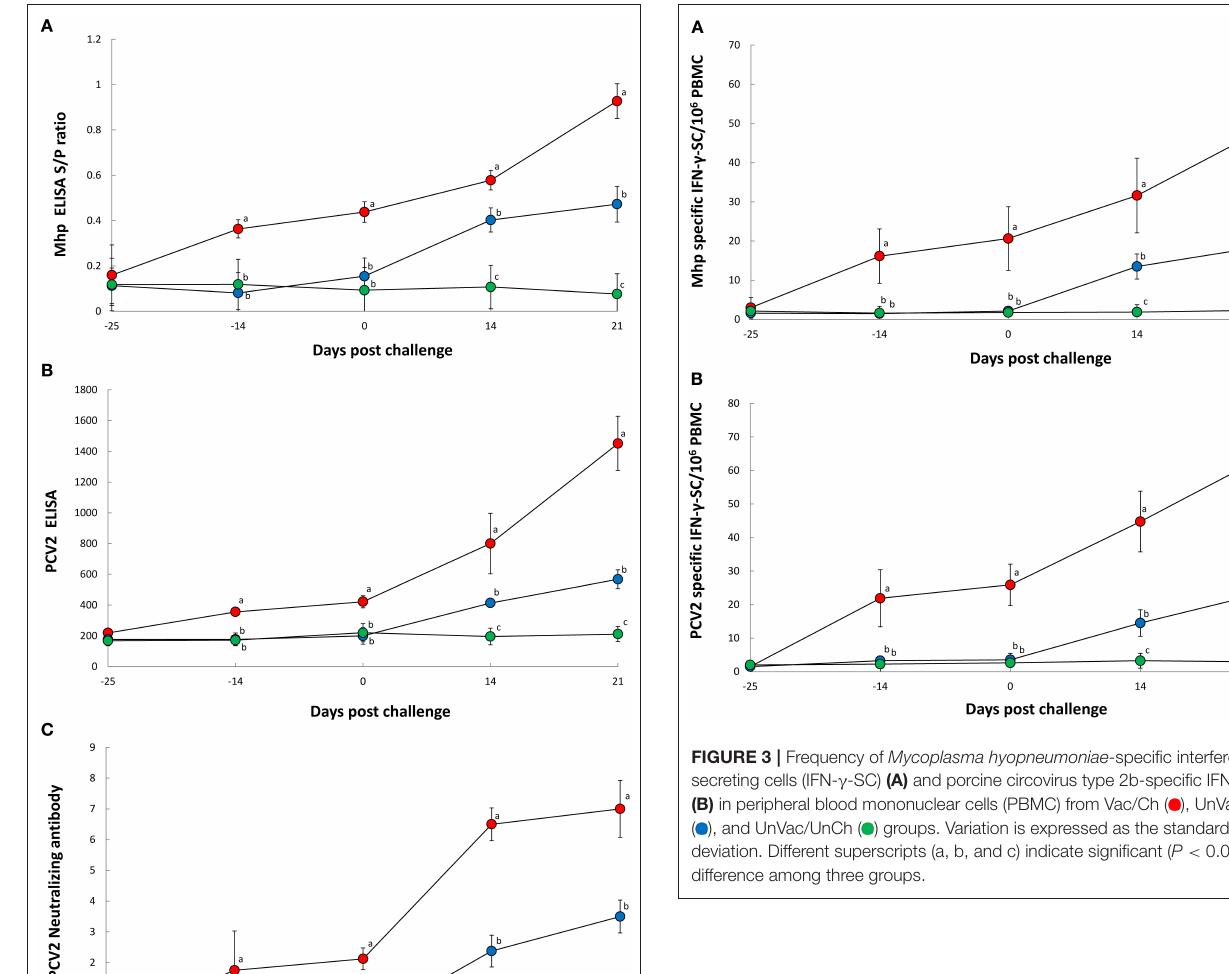
and PCV2b- ( Figure 3B ) specific IFN- γ -SC in their PBMC from − 14, 0, 14, and 21 dpc when compared with the UnVac/Ch group. There was a correlation between the number of genomic copies of M. hyopneumoniae in the nasal swabs and numbers of M. hyopneumoniae -specific IFN- γ -SC ( r = − 0.758, P = 0.029). M. hyopneumoniae and UnVac/UnCh